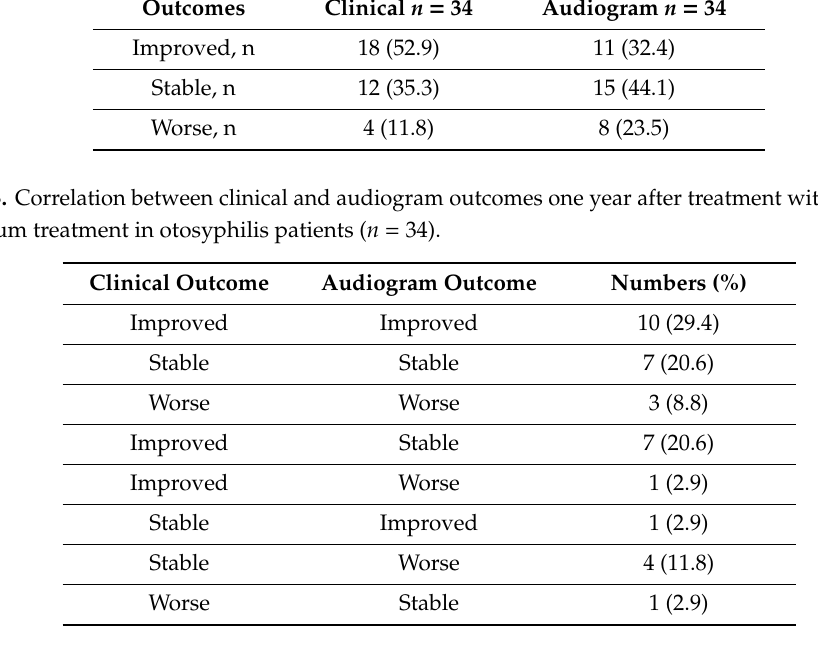
Table 4. Clinical factors of patients with otosyphilis who were treated with penicillin G sodium, categorized by audiogram improvement one year after